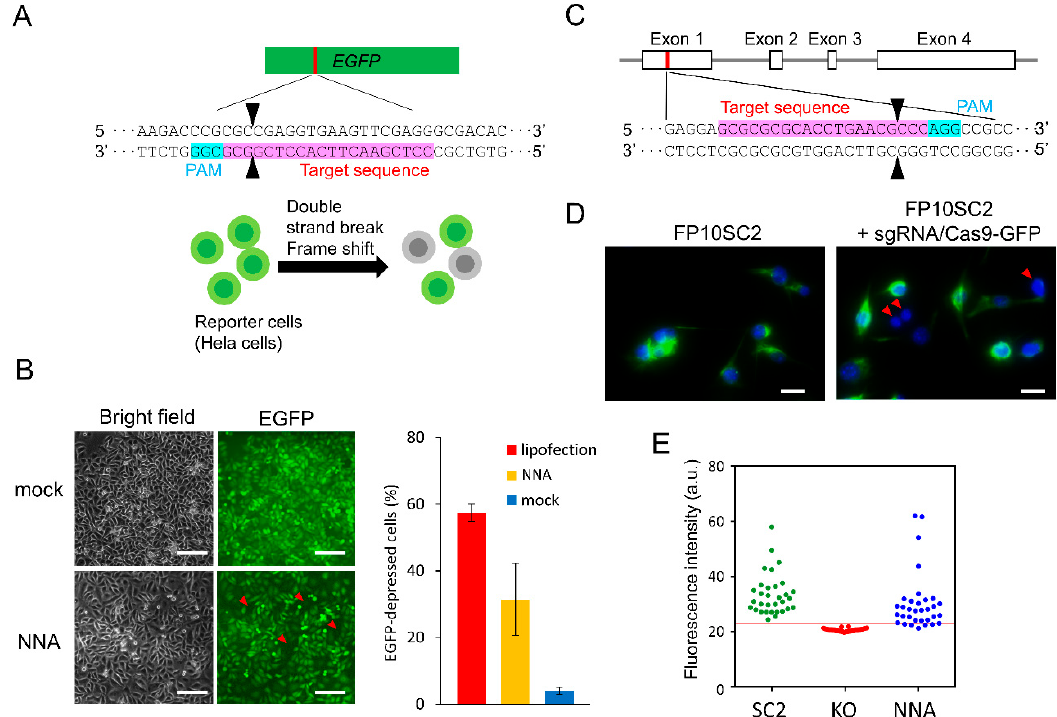
Figure 3. Gene disruption in mammalian cells by direct delivery of the RNP complex. ( A ) Schematic of the EGFP disruption. ( B ) EGFP disruption in reporter cells ( n = 3). Left panel shows bright field and fluorescence images of the portion of cells that were cultured for 48 h after the insertion of bare NNA (mock) or RNP delivery using NNA. Scale bar: 200 µ m. Right panel shows the ratio of EGFP-depressed cells. RNP was introduced by lipofection (red) or NNA (yellow), respectively and the mock-treated cells was showed in blue. ( C ) Schematic representation of the mouse nestin gene and the sgRNA targeting sequence. ( D ) Immuno-stained FP10SC2 cells after delivery of RNP with the NNA (right) and negative control (left). Green indicates nestin, and blue indicates the nucleus stained with DAPI. Scale bar: 20 µ m. ( E ) Fluorescence intensity threshold for estimating nestin deficient cells. Parental cells (SC2; green; positive control), nestin knockout cell line 5NK-H10 (H10; red; negative control), and RNP introduced cells by NNA (blue). Red line indicates the average fluorescence intensity of H10 plus five SD. The demonstrated plot and threshold were based on an experiment replicated 7 times. The target sequence of sgRNA and protospacer adjacent motif (PAM) are depicted in pink and light blue. Black arrowheads indicate cleavage sites. Red arrowheads indicate target-protein-deficient cells.